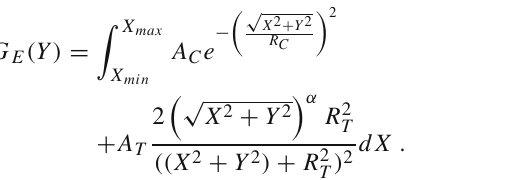
started within 600 µ m of the pad center were used. In addi- tion, the difference between the extrapolated hit position in information, was required to be smaller than 2 pads (3.6